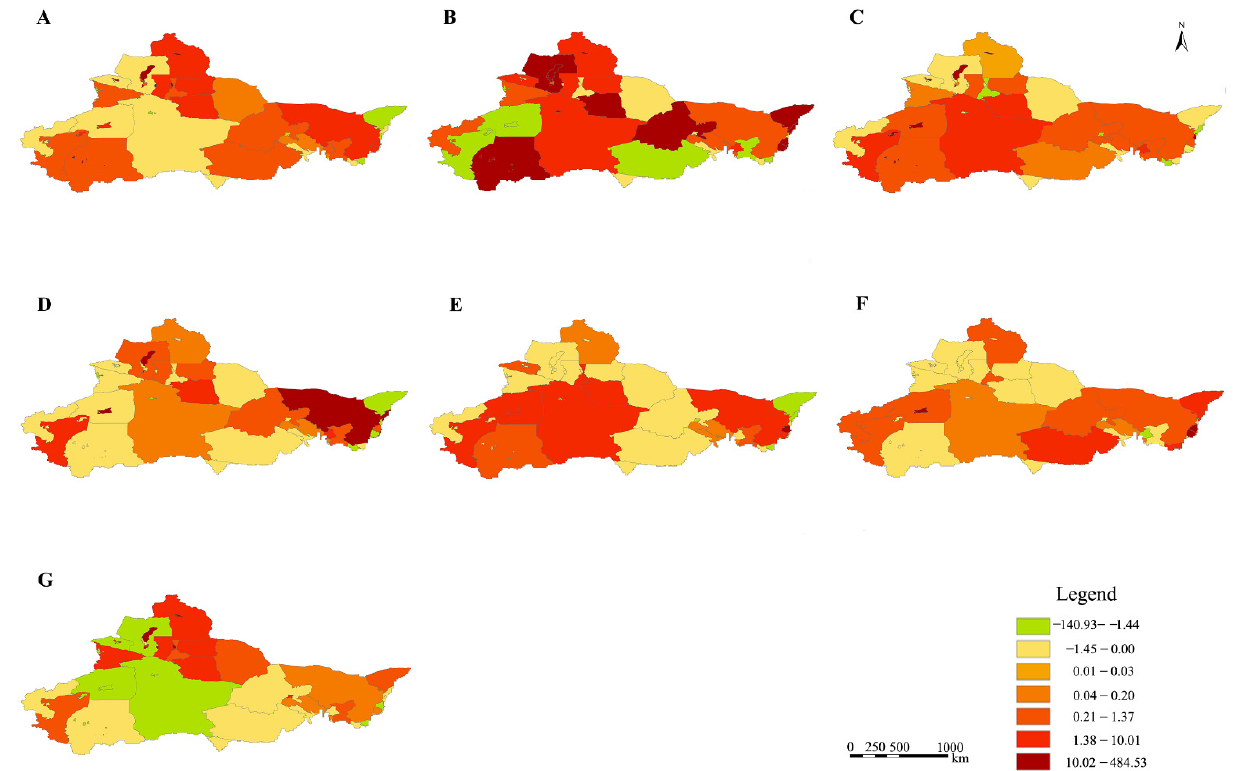
Figure 3. Relative dynamic degree of forests in the arid desert region of Northwest China, ( A )